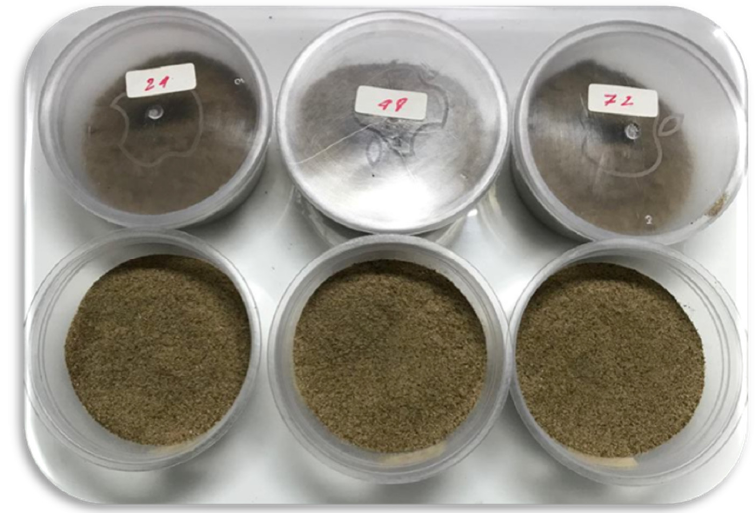
Figure 2. The storage conditions of the materials including lidded and open storage.